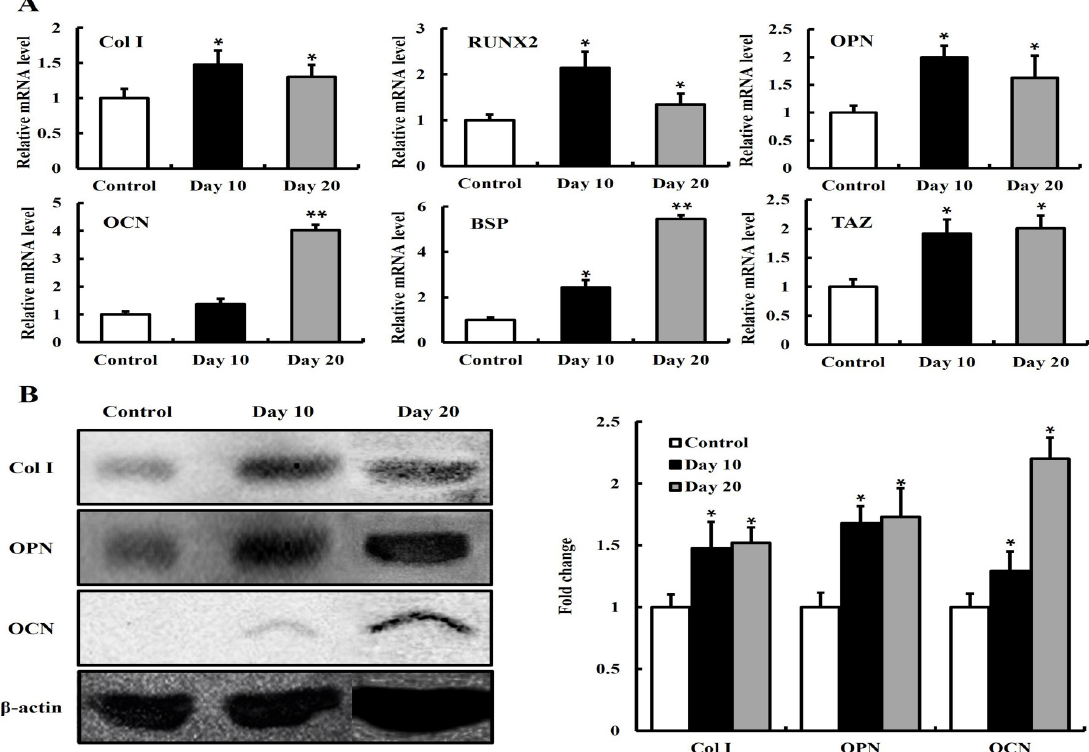
Fig 8. Osteogenic differentiation activities of hMSCs on the FN9-10 ELP -titanium discs for 20 days. The titanium discs were immersed overnight in 10 μ g � mL − 1 of FN9-10 ELP at 4˚C, while the non-coated discs served as the control. The hMSCs were seed at a density of 5 × 10 3 cells/disc and incubated for 20 days at 37˚C. (A) The mRNA levels of osteogenesis-related genes (Col I, RUNX2, OPN, OCN, BSP, TAZ) were analyzed via real-time PCR, and the comparative mRNA levels of each gene were evaluated relative to that of the β -actin as an internal control. The osteogenic differentiation activities are presented as the mean ± SD (n = 3). p < 0.05 and p < 0.01. (B) The protein levels of Col I, OPN, and OCN were analyzed via western blotting. Band density values of Col I, OPN, and OCN were normalized with β - actin and these proteins were represented as an arbitrary ratio compared to control